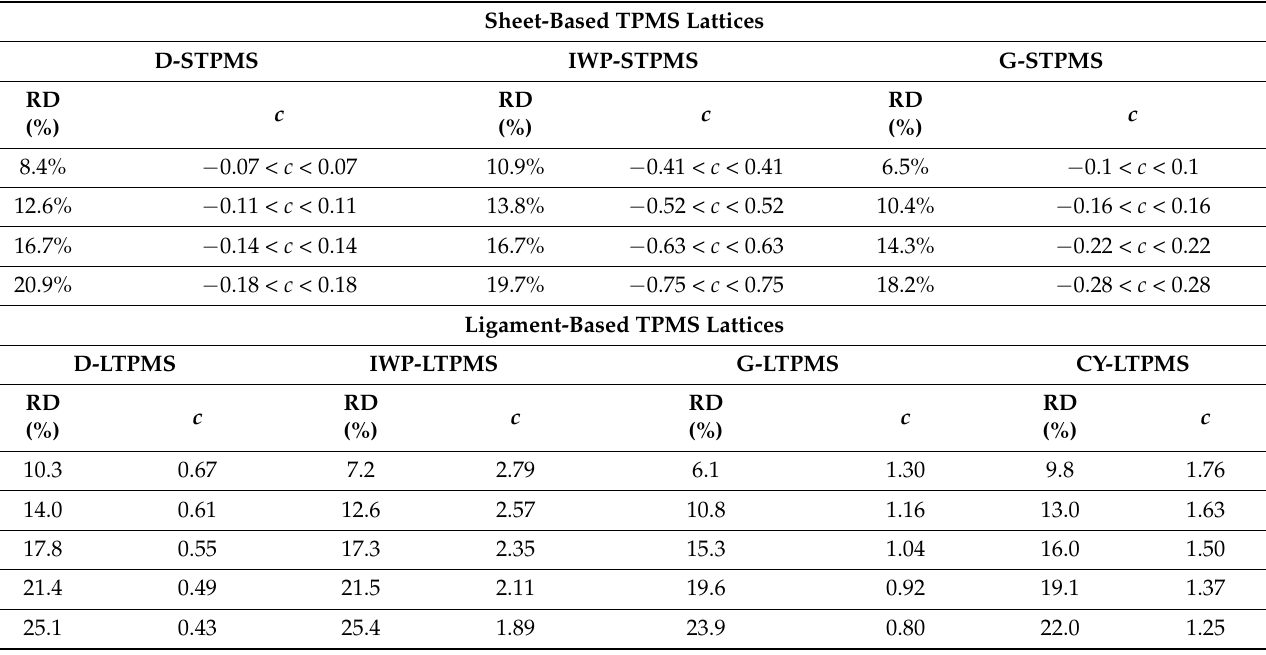
Table 2. Values of the level set constant c corresponding to each designed relative density (RD) for each TPMS lattice: sheet-based TPMS and ligament-based